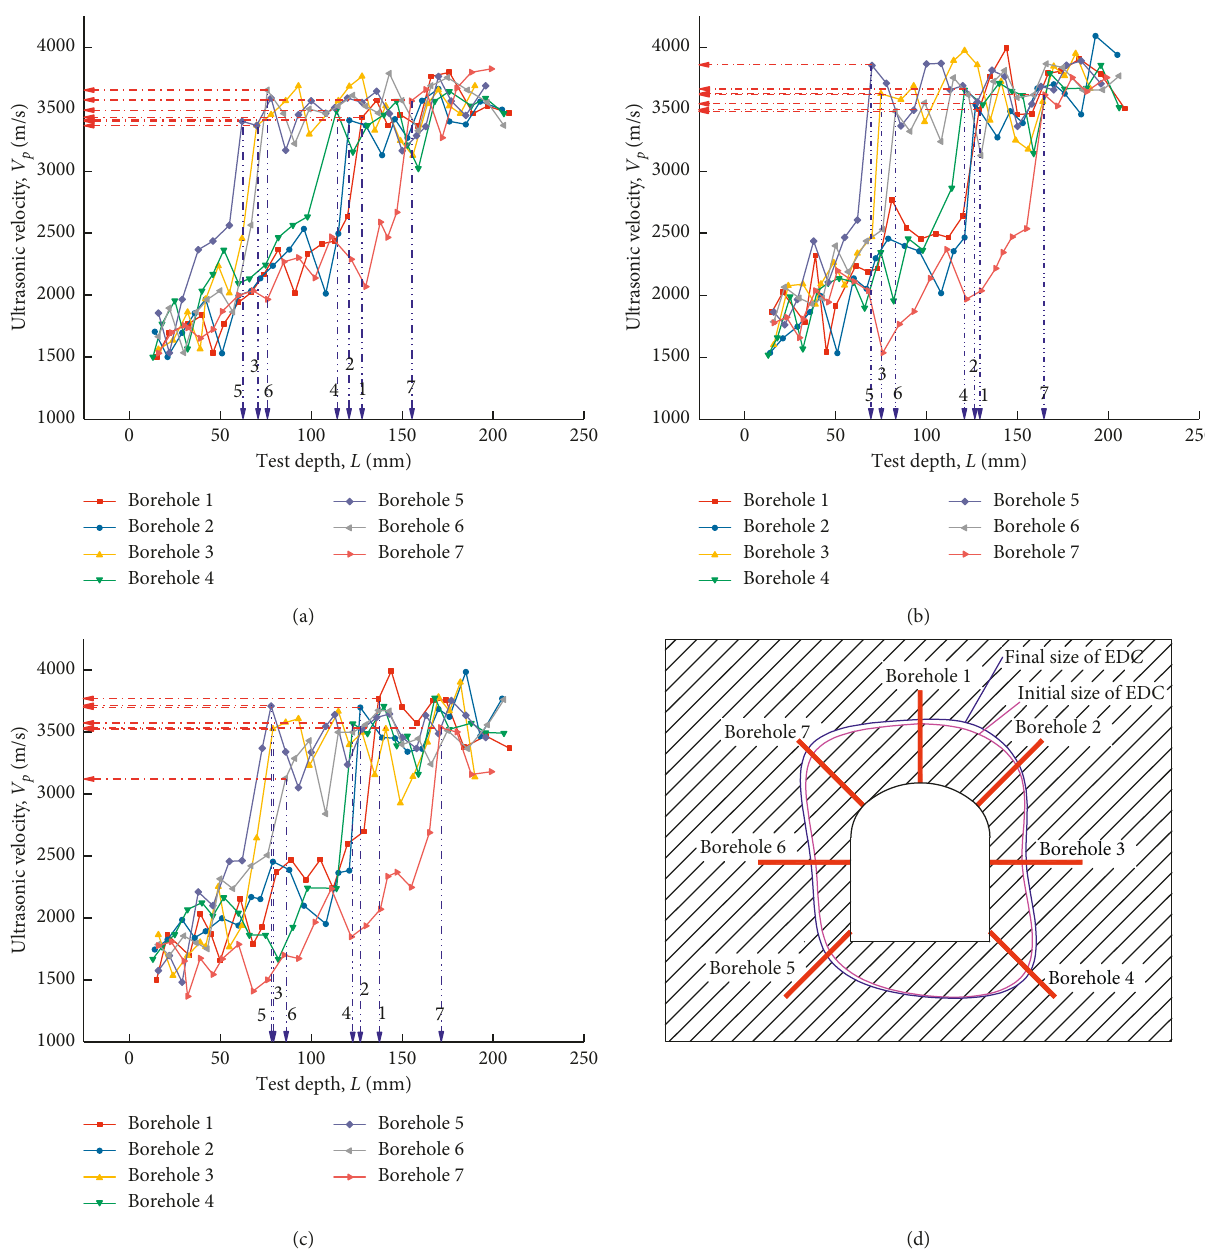
Figure 6: Relationship between V p and L of different dates in Section 2: (a) test results on March 22, (b) test results on March 30, (c) test results on April 7, and (d) initial size and final size of the